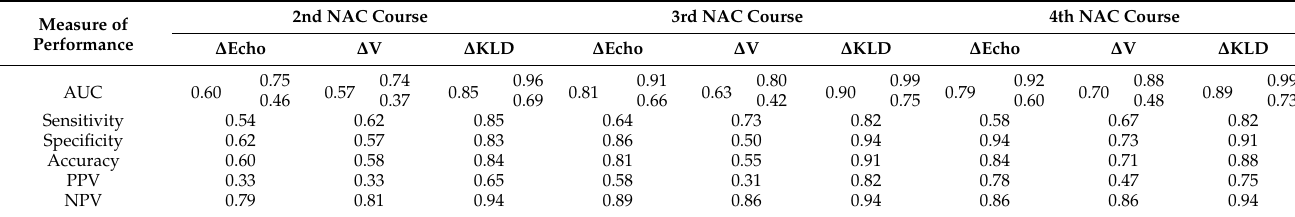
Table 3. Results of statistical analysis of changes in echogenicity, volume, and ∆ KLD parameter after two, three, and four courses of NAC for non-responding tumors (RMC ≥